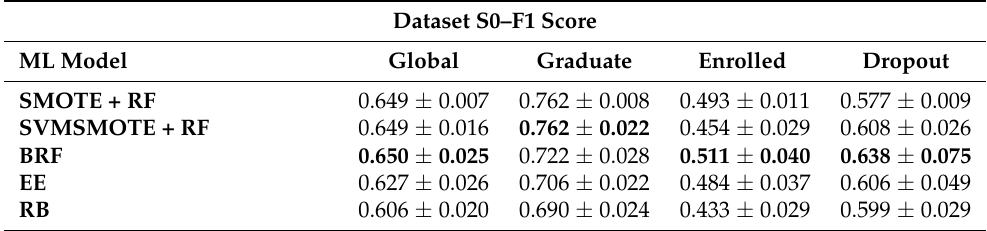
Table 6. F1 score evaluation for each class for each learning model built with information at the time of enrollment. Values represent mean and standard deviation.